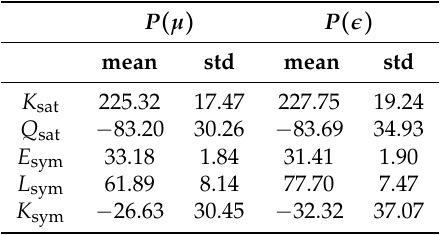
Table 2. The mean and standard deviation (std) of the empirical parameters. All the quantities are in units of